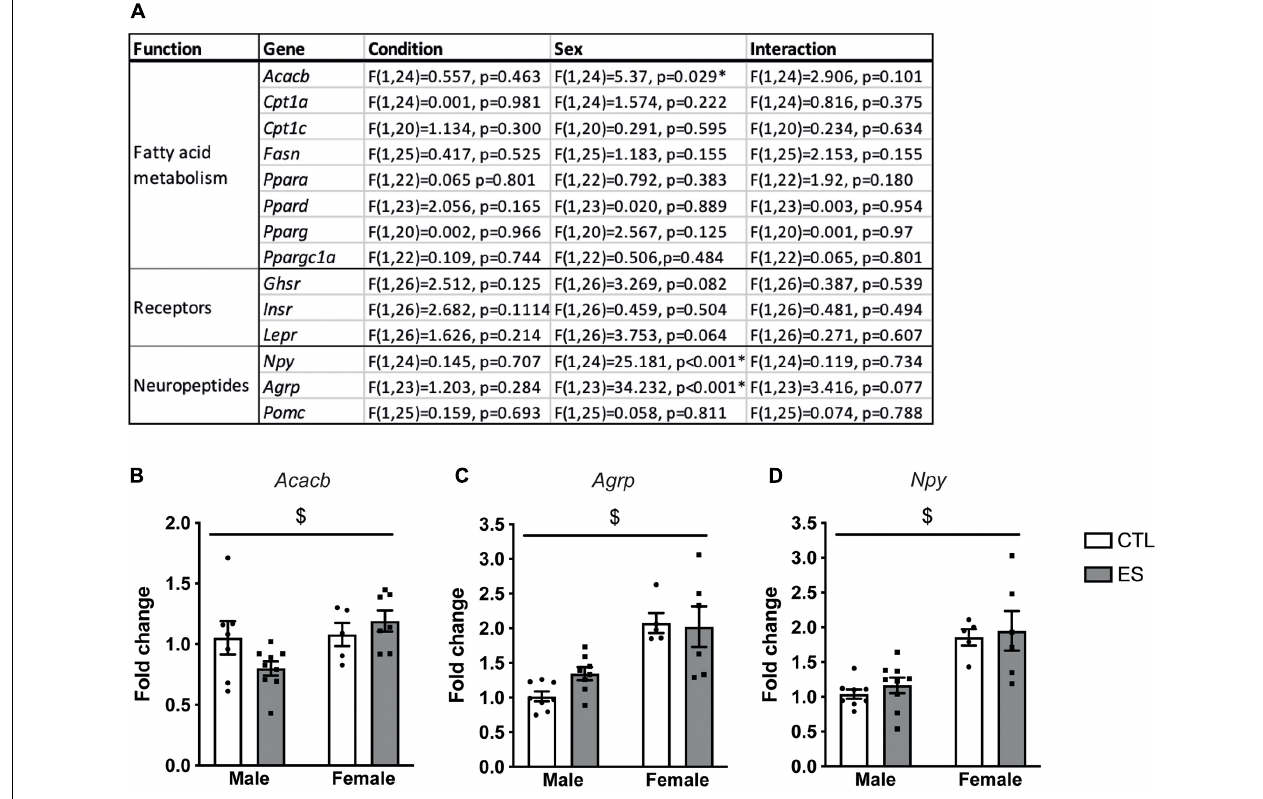
FIGURE 2 | (A) Effects of ES and sex on hypothalamic gene expression in adulthood. (B) Acacb expression was higher in females. (C) Expression of Agrp was higher in females. (D) Npy expression was higher in females. Indicated is mean ± SEM, p < 0.05. * = significant effect; $ main effect of